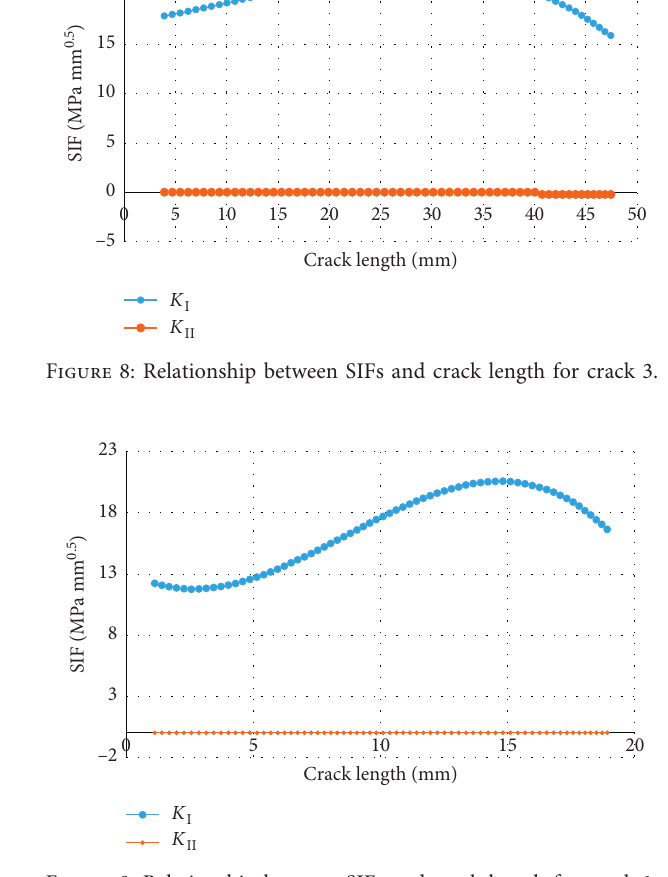
Figure 9: Relationship between SIFs and crack length for crack